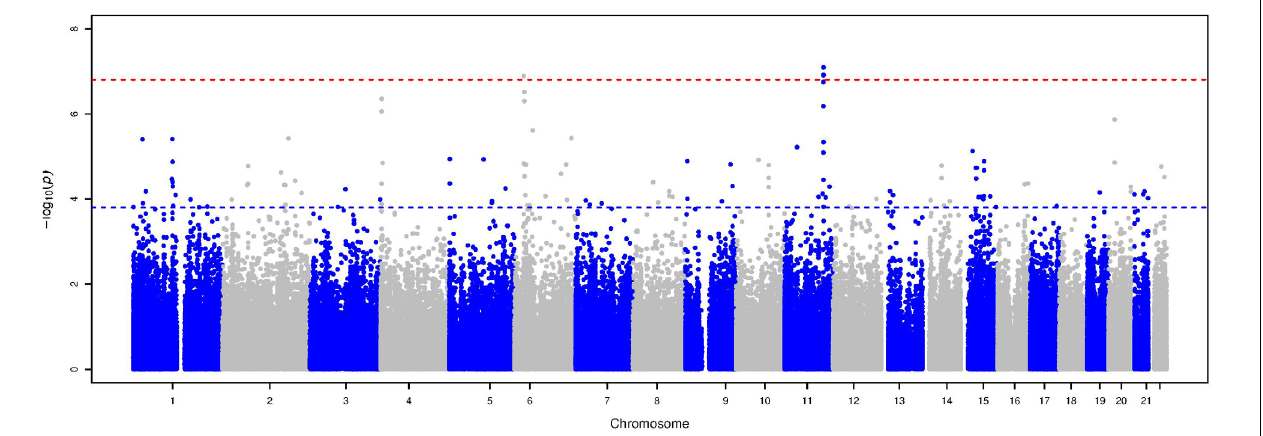
FIGURE 1 | Manhattan plot of the association analysis with LTL in the ERF study. This plot shows –log10 transformed p -values ( y -axis) for all variants present in the association analysis according to their position on each chromosome ( x -axis). The red dashed line represents the Bonferroni corrected p -value threshold for significance ( p -value < 1.42 × 10 − 7 ), while the blue dashed line represents the p -value threshold for suggestive significance ( p -value ≤ 1.42 × 10 − 4 ).